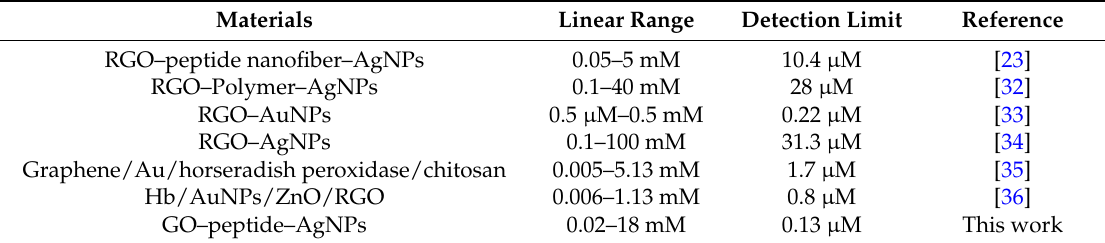
Table 1. Comparison of electrochemical H 2 O 2 sensors based on graphene-NPs nanohybrids.